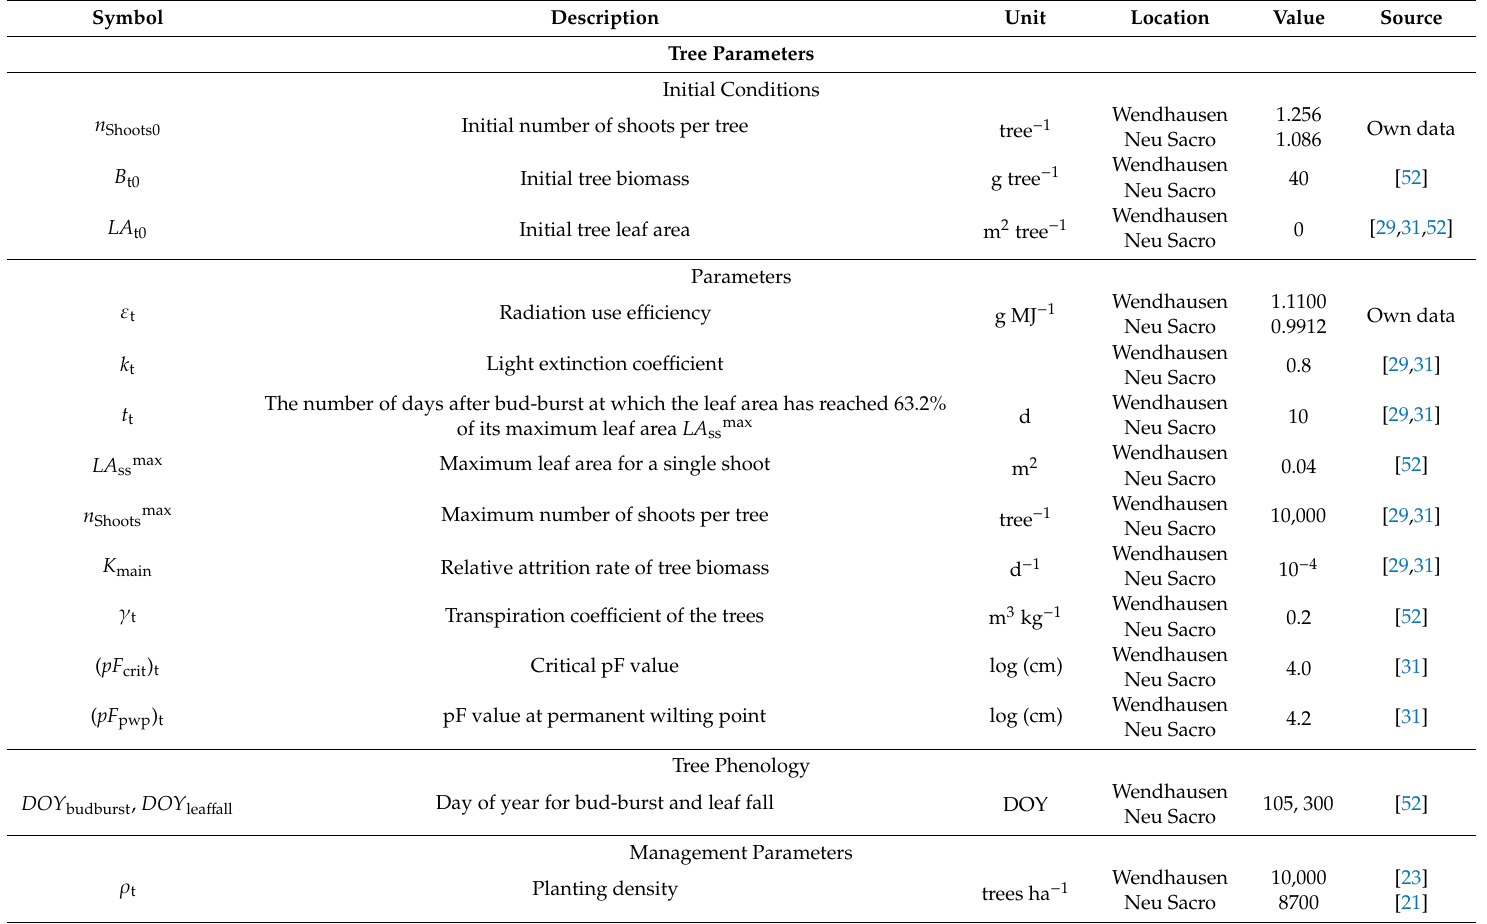
Table A1. Tree parameter values used for the parametrization of the Yield-SAFE